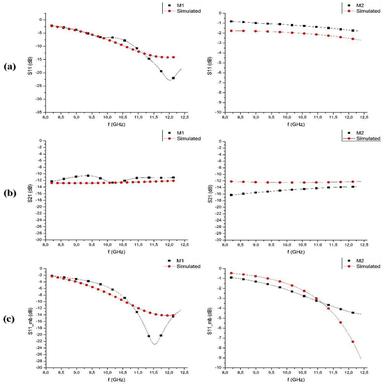
Different scattering parameters measured and simulated for M1 and M2: (a) Reflection in transmission, (b) Transmission and (c) Reflection metal backed.